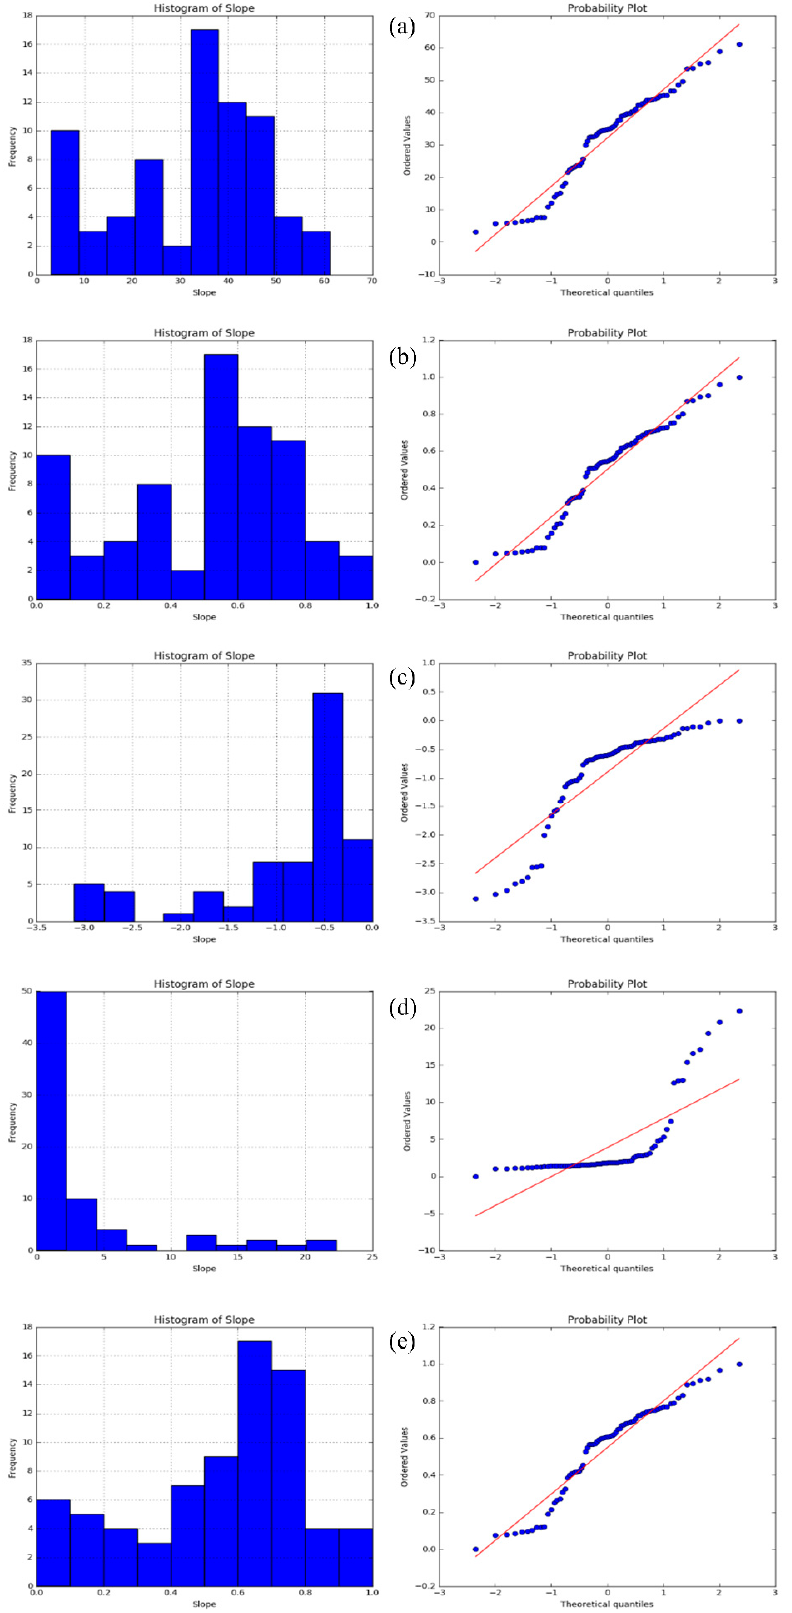
Figure 5. The histogram and the Q-Q plots of the slope values: ( a ) original slope values; ( b ) Std-X; ( c ) Log-X; ( d ) Rec-X, and ( e ) Power-X.